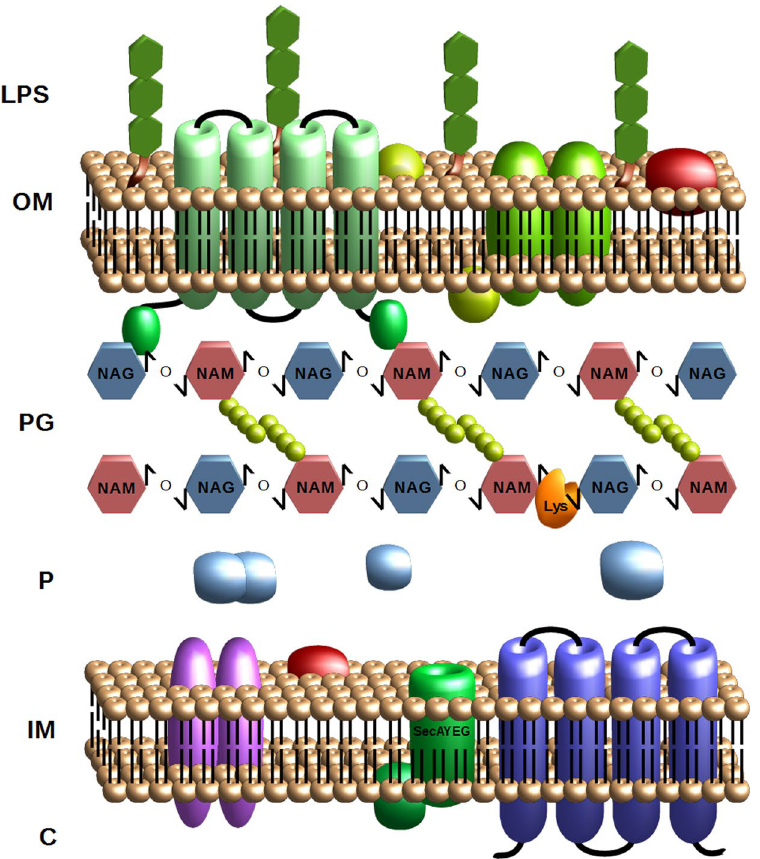
Figure 1. Generic representation of the Gram-negative subcellular fractions. The lysozyme catalytic action is illustrated. LPS = lipopolysaccharide; OM = outer membrane; PG = peptidoglycan; P = periplasm; IM = inner membrane; and C =